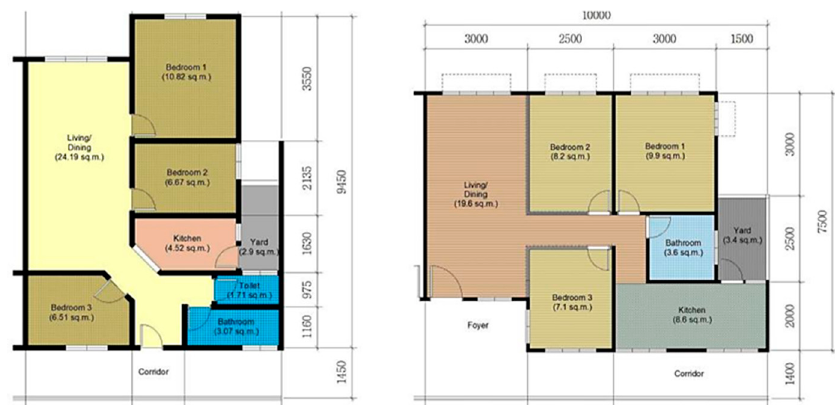
Figure 4. The unit plan layouts for the People’s Housing Programme (PPR) first-generation units ( left ) and the new proposal for the ‘airhouse’ standard ( right ) [4].